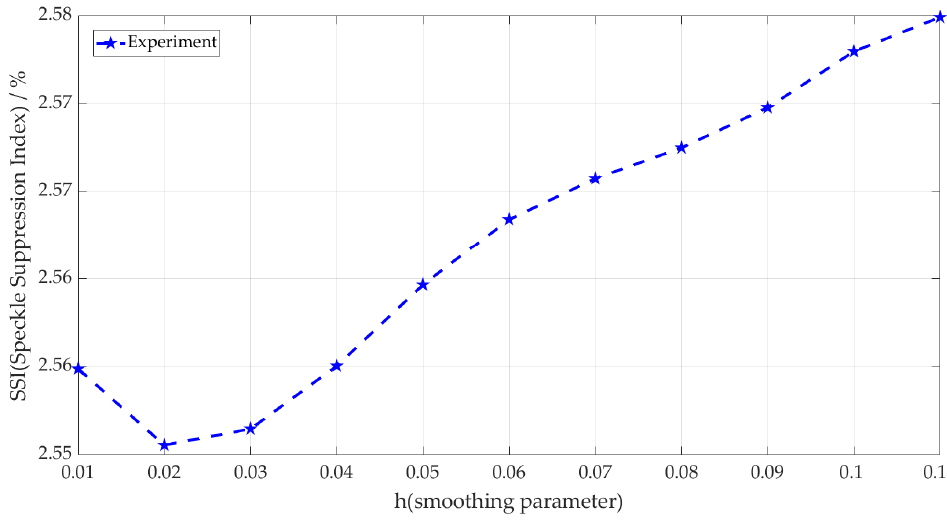
Figure 8. Comparison graph of weight function before and after optimization.